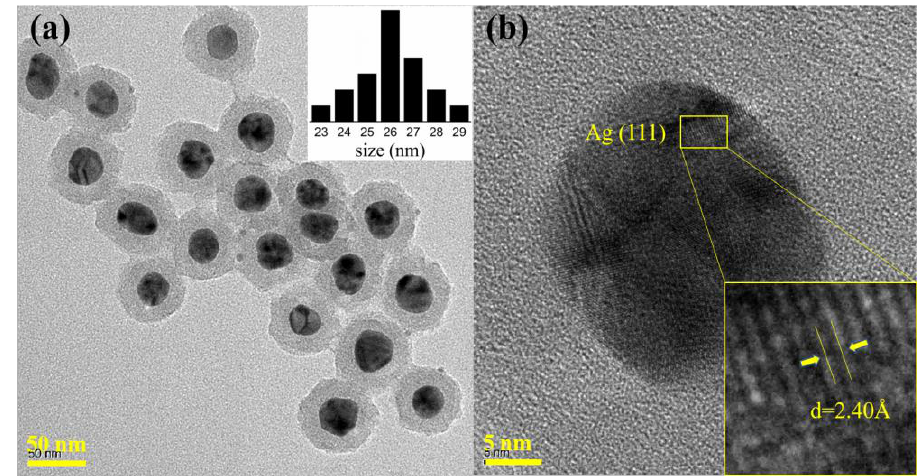
Figure 1. ( a ) TEM image and size distribution results of Ag@SiO 2 NPs; ( b ) HRTEM image of a Ag@SiO 2 NP.